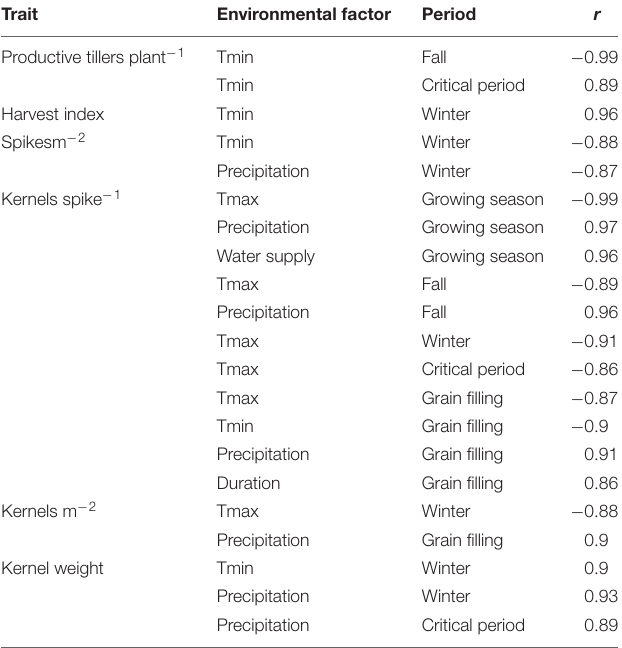
TABLE 2 | Correlations between yield components, averaged across four varieties and six management intensities, and daily average or cumulative values of environmental factors during specific crop development